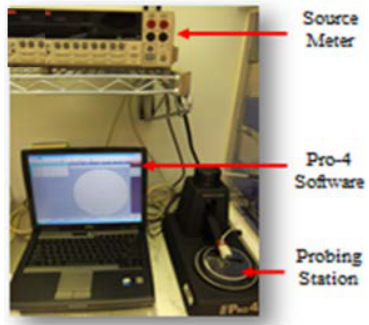
Figure 10. Four point probe device.